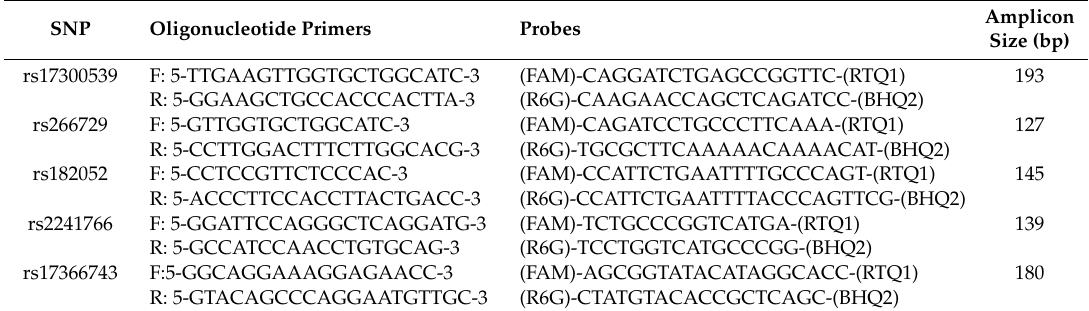
Table 1. Primer and probe sequences for the analysis of single nucleotide polymorphisms (SNPs) of the ADIPOQ gene.